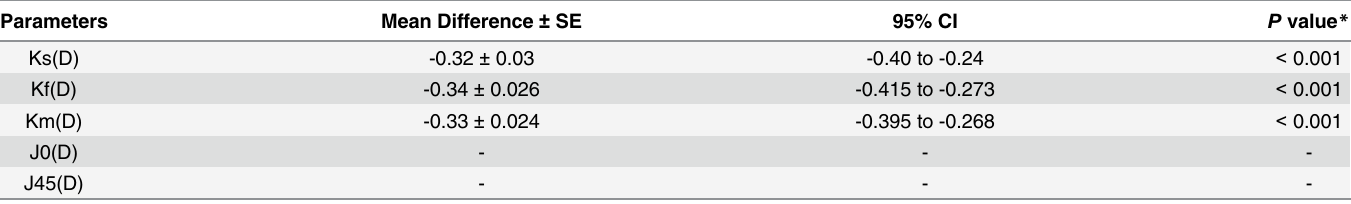
Table 10. Comparison of Ks, Kf and Km obtained by iTrace and Topolyzer. (Note: Ks: steep keratometry, Kf: flat keratometry, Km: mean keratometry, D: diopter, SD: standard Error, 95% CI: 95% consistent interval, * Bonferroni corrected.)